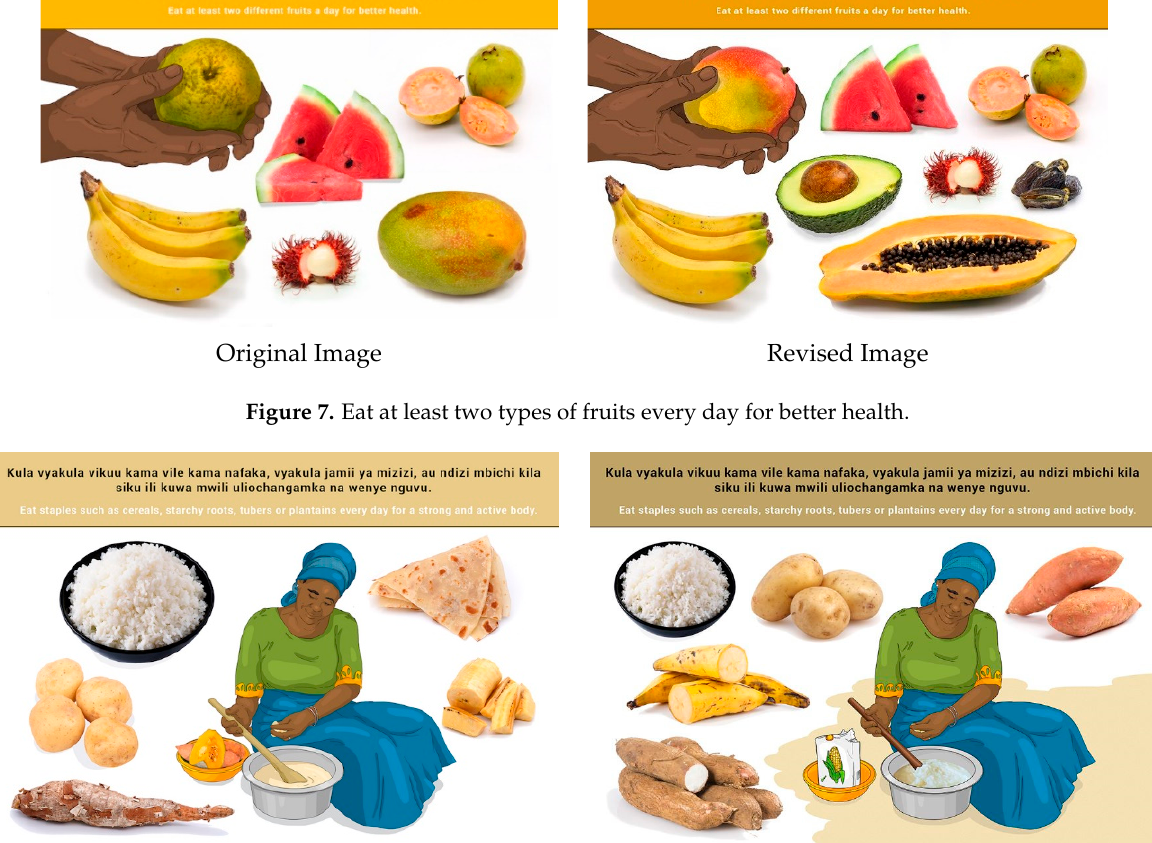
Figure 6. Revised message and image 4 for Mainland and Zanzibar: Eat different coloured vegeta- bles such as tomatoes, onions, carrots, okra and green leafy vegetables every day to prevent and reduce risk of diseases.